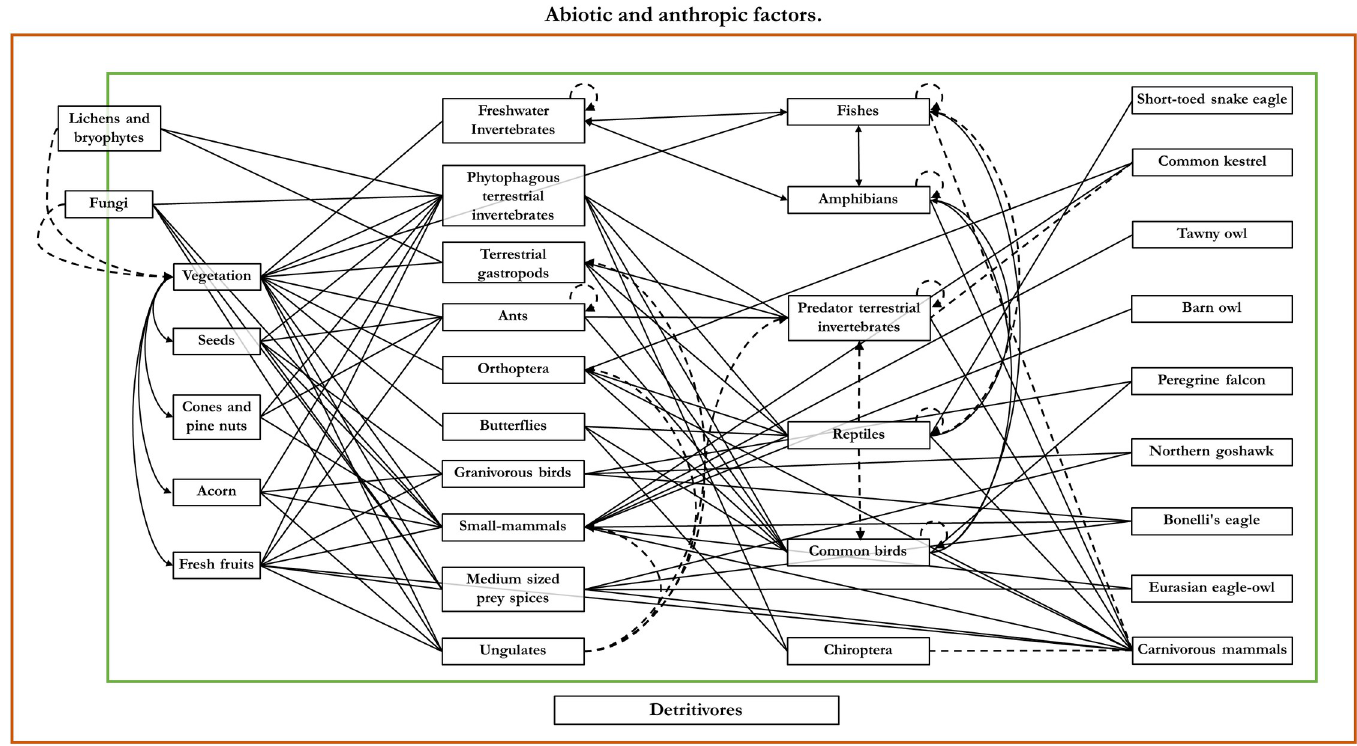
Fig 2. Interactions between the monitoring candidates to elucidate ecological processes. Diagram of the possible interactions that are established between the monitoring candidates, where highlight five main groups of organisms in the trophic network, the detritivores (green box), the primary producers, the primary and secondary consumers, and the predators. However, within these groups, interactions occur, even within the same species communities. On the other hand, this entire complex trophic network is conditioned by abiotic and anthropogenic external ecosystem disturbances (ecosystem disturbances; red box), such as climatology, perturbations, pollution, forest management, etc. Continuous lines denote direct relationships, while discontinuous lines describe diffused relationships often characteristic of opportunistic species.